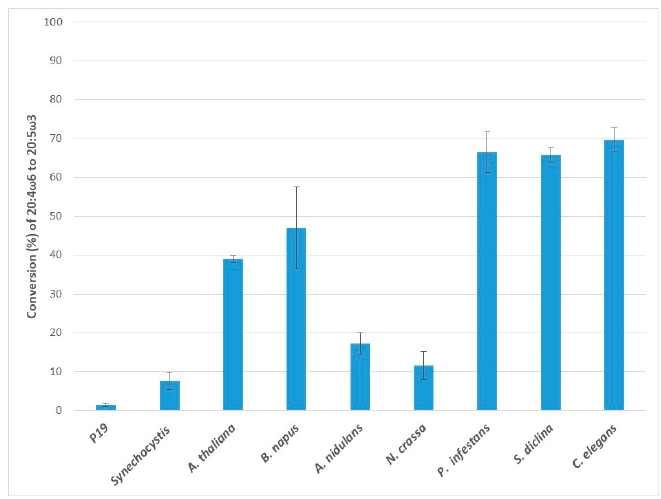
Figure 4. Enzymatic activities of transiently expressed ω 3Ds from various sources in N. benthamiana leaves on 20:4 ω 6 substrate. ω 3D activities were determined by measuring the conversion rate of provided 20:4 ω 6 substrate to 20:5 ω 3 in leaves expressing p19 silencing suppressor only as a control or the appropriate ω 3D with p19. The error bars denote the standard deviations of the means from triplicate